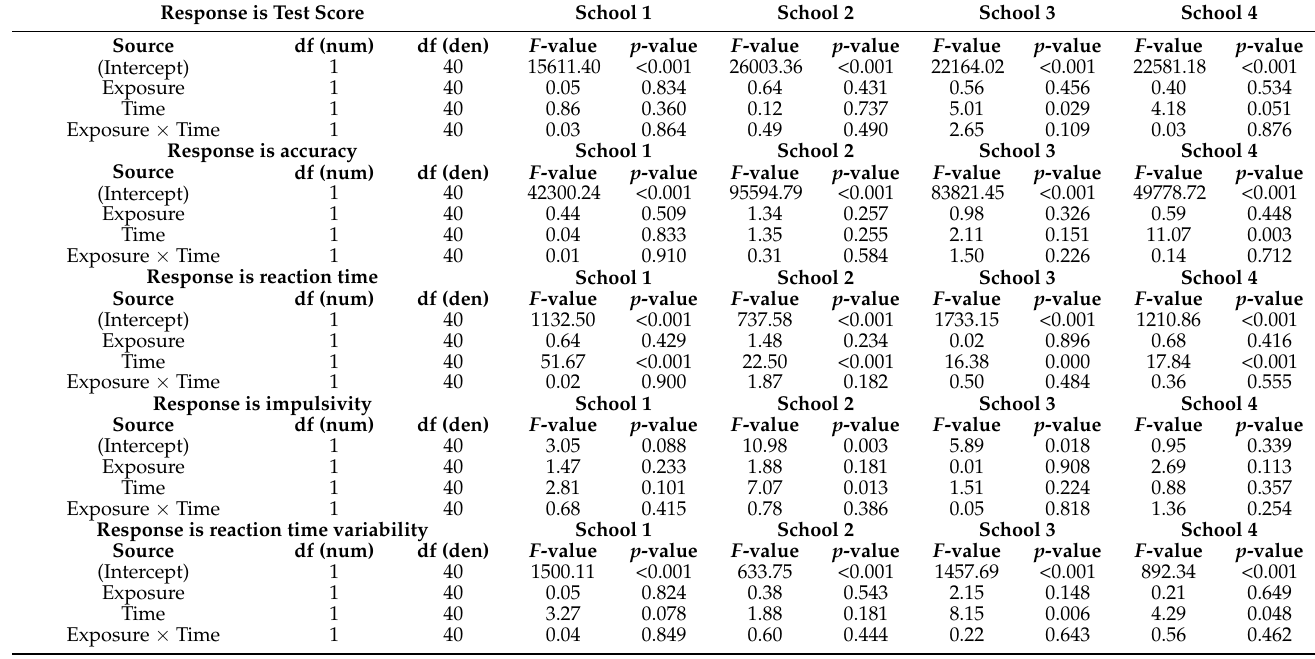
Table 2. Hypothesis testing for the five response variables considered in the experiment.